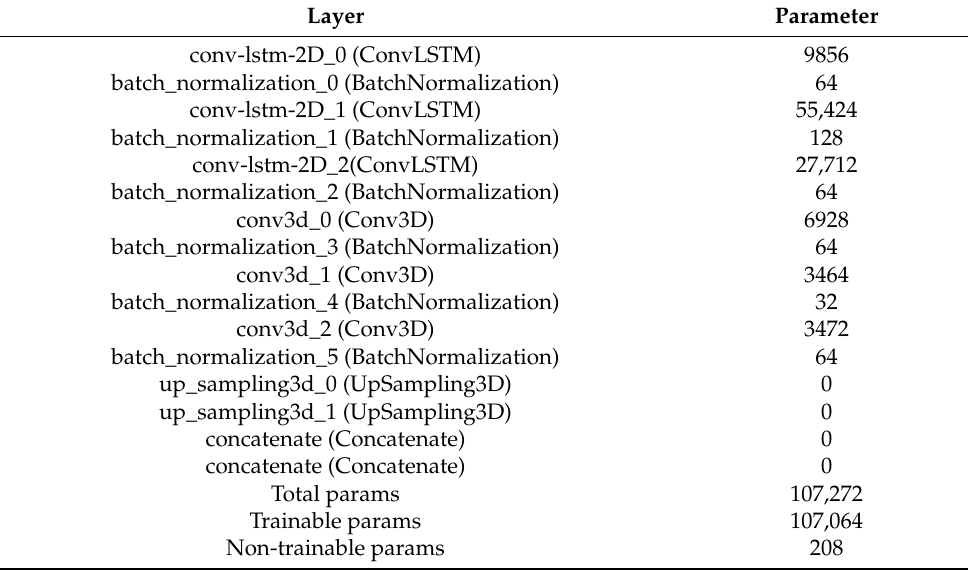
Table 2. The parameters of the entire